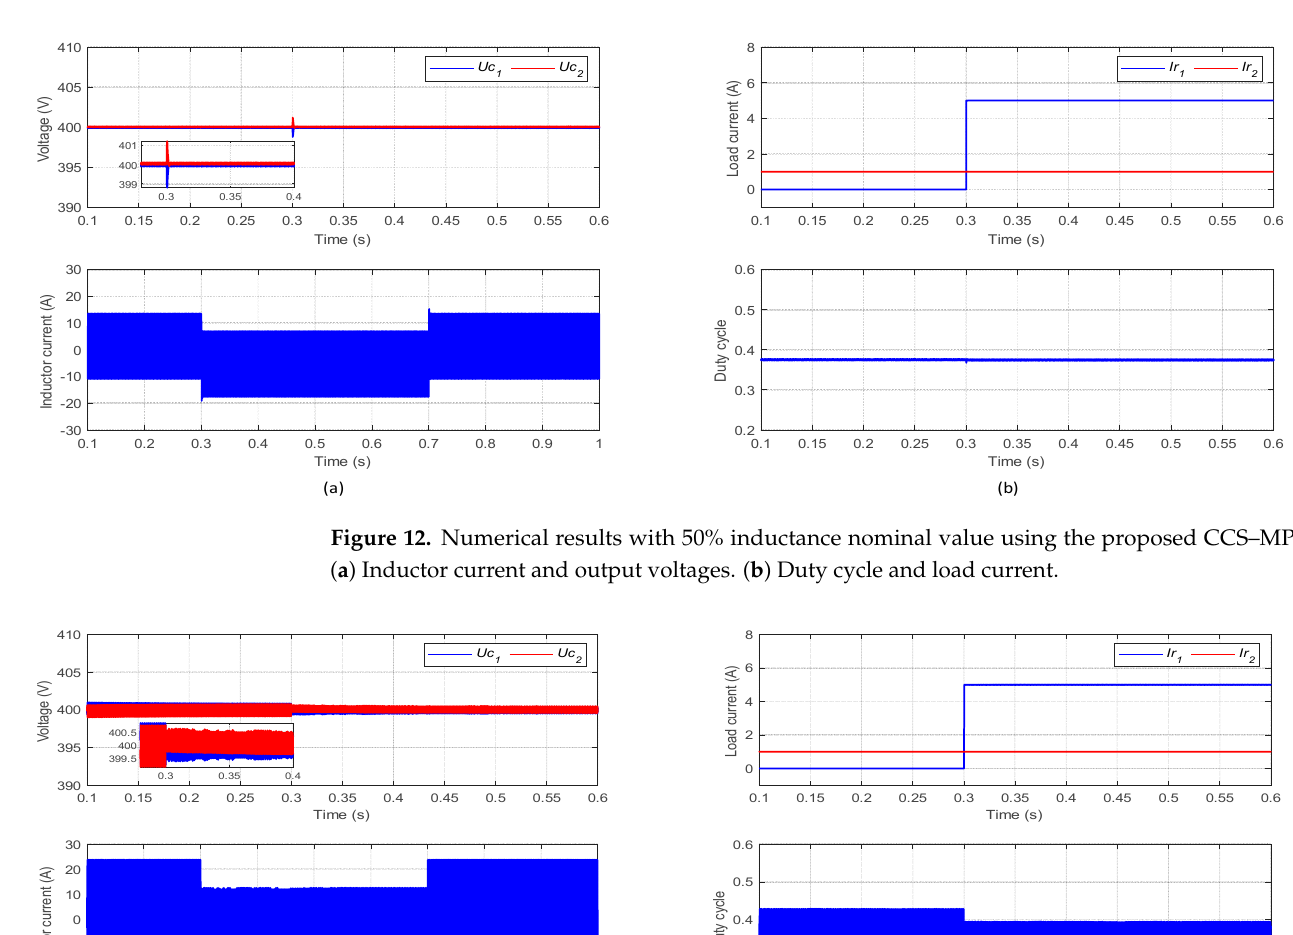
(b) Figure 11. 𝐼 𝑅1 Load transient response using the GA – PI controller. ( a ) Inductor current and output voltages. ( b ) Duty cycle and load current. 5.3. Parameter Robustness Analysis To confirm the parameter robustness of the proposed CCS-MPC controller against parameter uncertainty, the simulation results were compared with the designed GA-PI controller by changing the inductance and capacitance of the balancing converter. Firstly, the proposed CCS-MPC and conventional GA-PI controller with a nominal inductance of 5 mH were tested at the 50% inductance nominal value. Figure 12 shows the output voltages and inductor current of the proposed CCS-MPC scheme with an in- ductance of 2.5 mH, and Figure 13 depicts the output voltages and inductor current of the GA-PI controller with a 2.5 mH inductance value. It is apparent that the conventional PI controller has an oscillatory behavior, while the CCS-MPC is more robust in case of an inductor parameter mismatch. Secondly, to verify the robustness of the proposed CCS-MPC against the capacitance